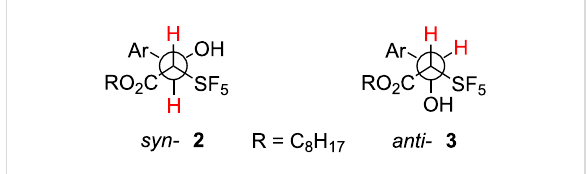
Figure 1: Newman projections of the syn - and the anti -diastereomeric aldol addition